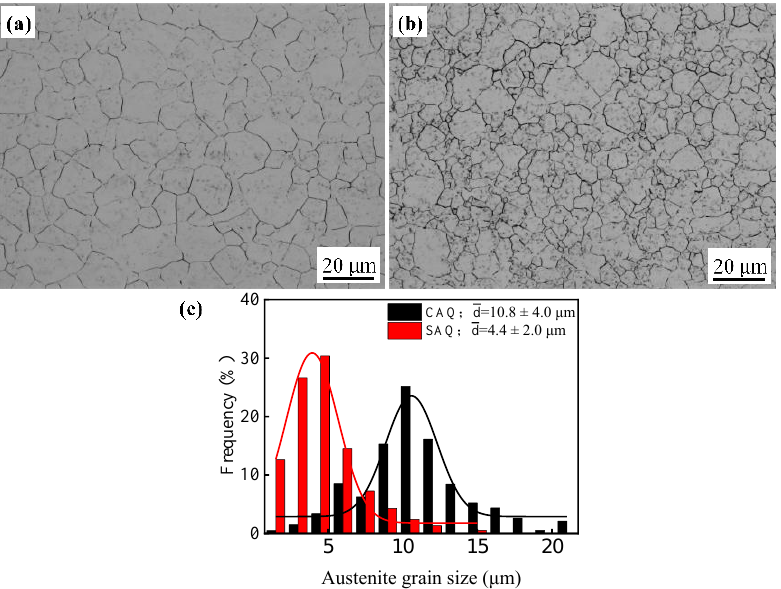
Figure 2. Effect of heating processes on PAGS: ( a ) CAQ; ( b ) SAQ; ( c ) distribution of PAGS.